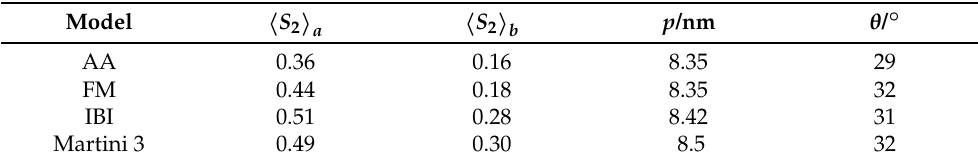
and (cid:104) S 2 (cid:105) ), helical pitch ( p ) and conical tilt angle ( θ ) for the AA a b